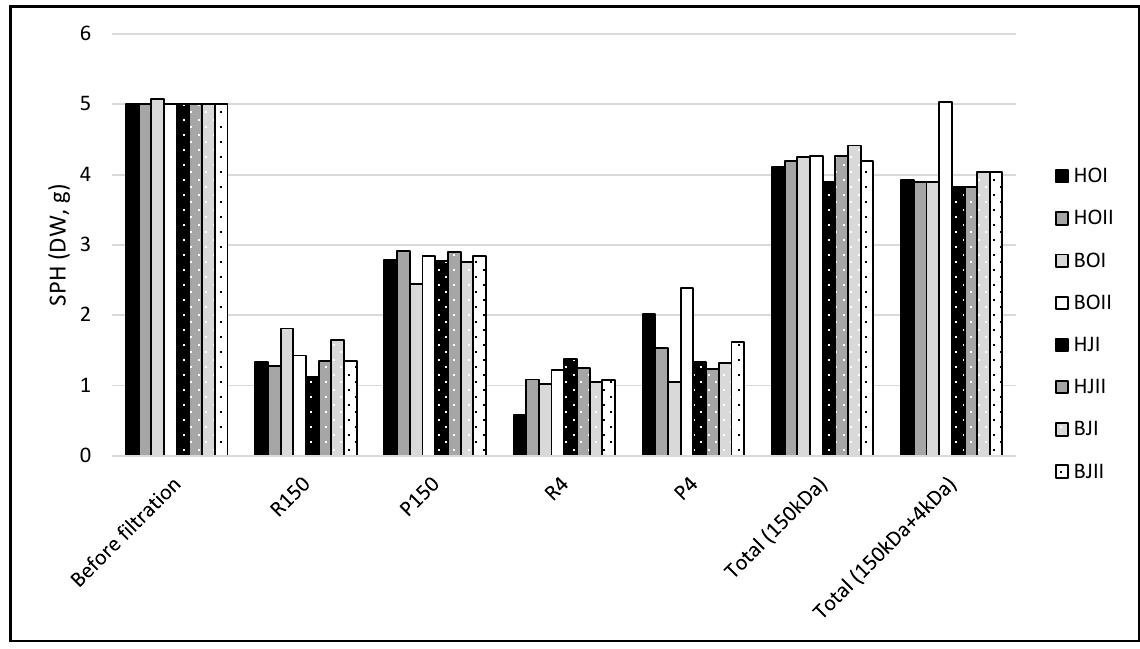
Figure 1. Mass distribution (n = 1) of saithe protein hydrolysates (SPH) before filtration and after filtration with 150 kDa cut-off ceramic membrane (retentate: R150, permeate: P150), and subsequently 4 kDa cut-off PESH membranes (retentate: R4, permeate: P4). Total mass of R150 and P150 (Total (150kDa)) and total mass of R150, R4, and P4 (Total (150 kDa + 4 kDa) is included. SPH were obtained from the enzymatic hydrolysis of heads (H) and backbones (B), in two bioreactors (I, II), from saithe caught in October 2019 (HOI, HOII, BOI, BOII) and January 2020 (HJI, HJII, BJI, BJII).